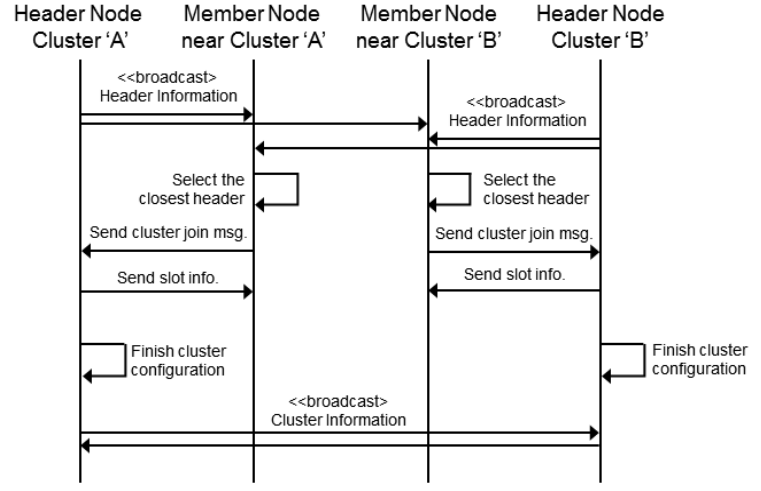
Figure 3. Advertisement phase sequence diagram setup-cluster phase sequence diagram.